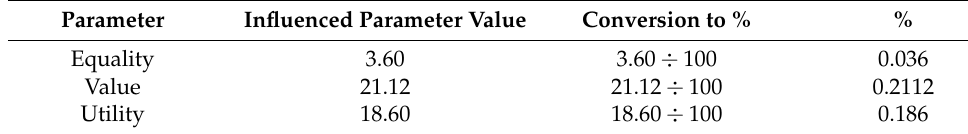
Table 12. Conversion of the satisfaction parameters to a percentage fraction.